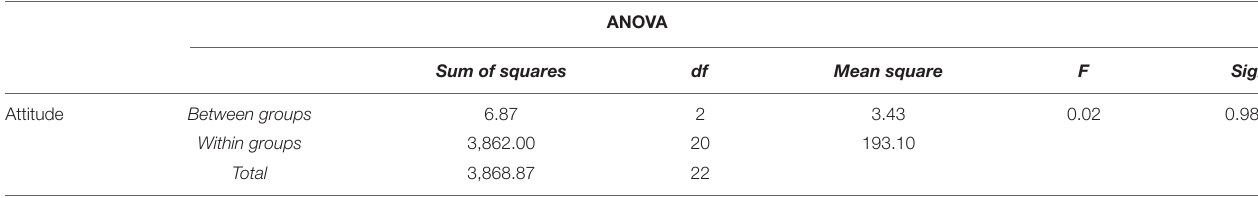
TABLE 8 | ANOVA Test for the relation between attitudes and computer